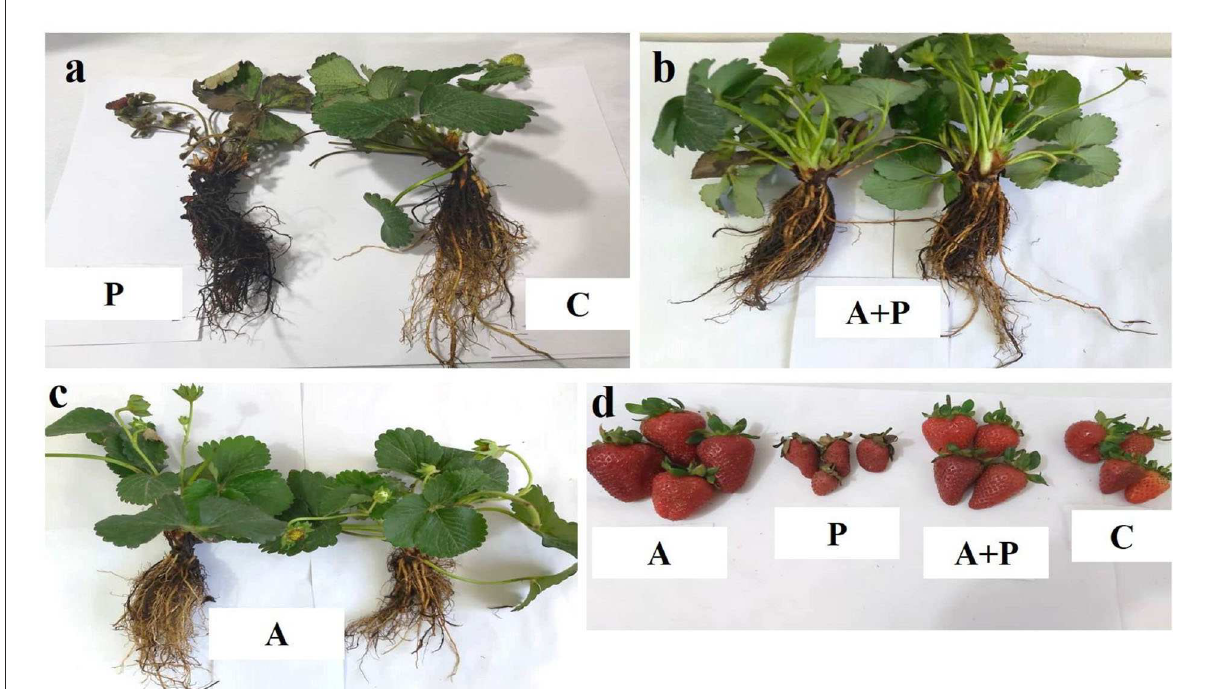
FIGURE1 Phenotypic responses of strawberry plant to the fungal pathogen ( M. phaseolina ) among different treatments 92 days post inoculation. (a) Symptoms of charcoal rot in the pathogen-inoculated plant (P) compared to non-inoculated plant (C); (b) vegetative growth of infected plants pre-treated with the alga ( S. angustifolium ) extract (A + P); (c) vegetative growth of non-inoculated plants pre-treated with the alga extract (A); (d) comparison of fruits from plants under the different